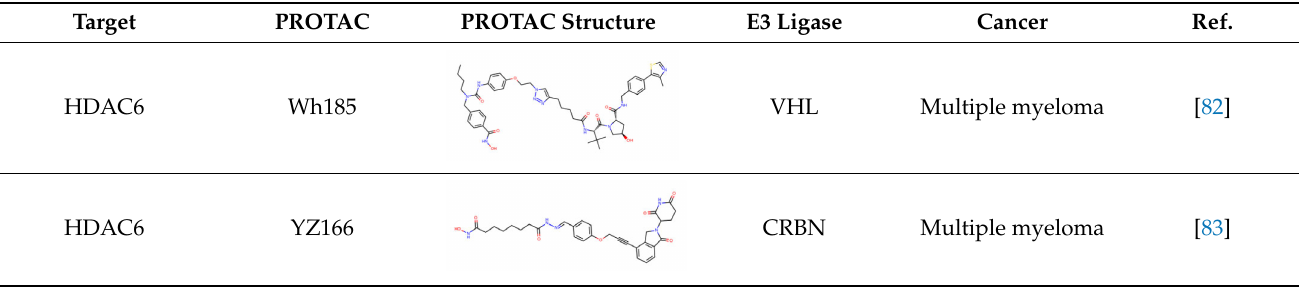
Table 2. PROTACs for Histone acetylation targets